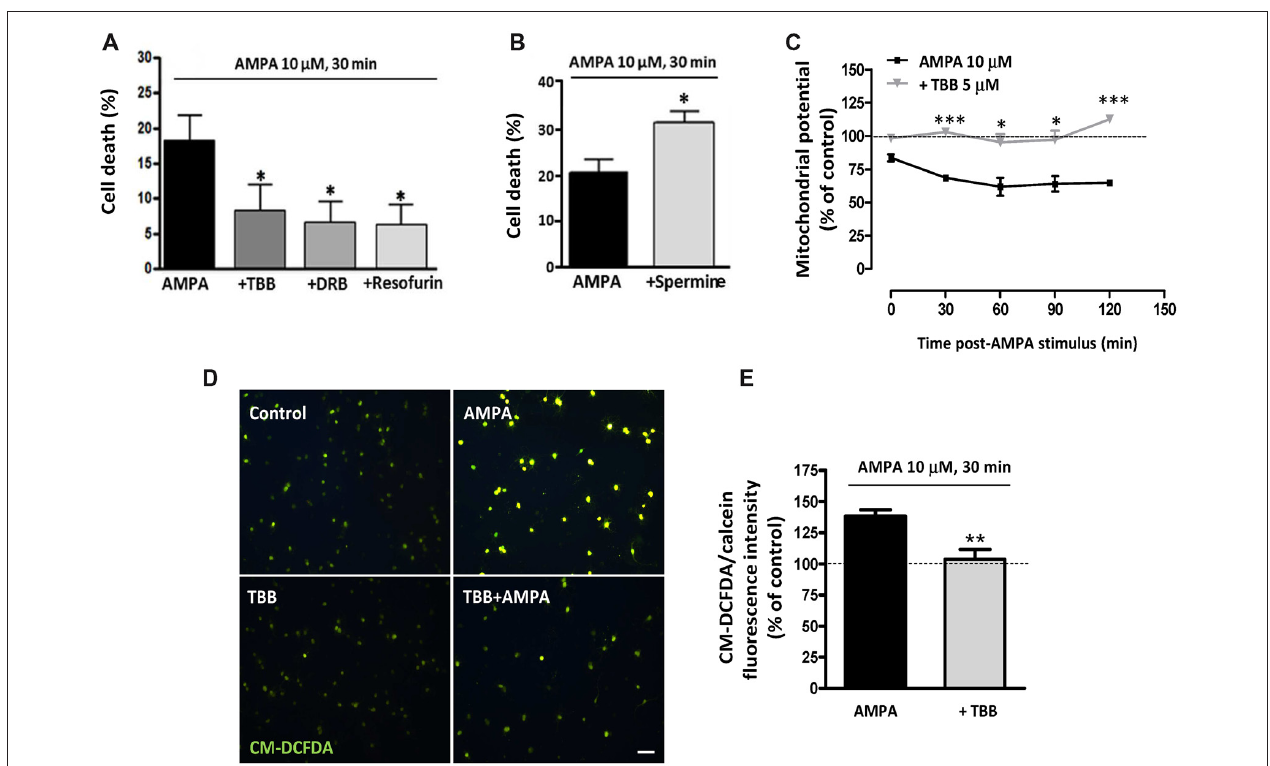
FIGURE 2 | CK2 inhibition protects rat oligodendrocytes from AMPA excitotoxic insults. Oligodendrocyte cultures were isolated from mixed glial culture and used for toxicity assays after 2 days in vitro in differentiation SATO medium. (A) Activation of AMPA receptors with 10 µ M AMPA applied together with 100 µ M cyclothiazide for 30 min, caused oligodendroglial cell death as measured by calcein-AM assay 24 h later. AMPA-induced cytotoxicity was significantly reduced in presence of CK2 inhibitors, 5 µ M TBB, 5 µ M DRB or 5 µ M resofurin and none of these CK2 inhibitors produced alterations in the oligodendrocyte viability when they were used without AMPA (data not shown). The data are shown as mean ± SEM ( n ≥ 4; ∗ p < 0.05 compared with cells treated with AMPA). (B) Pretreatment of cells with CK2 activator spermine (10 µ M) increased cytotoxic consequences derived from AMPA receptor activation in oligodendrocytes. Bars represent mean ± SEM ( n ≥ 3; ∗ p < 0.05 compared with cells treated with AMPA). (C) CK2 inhibitor TBB attenuated loss of mitochondrial membrane potential induced by activation of AMPA receptors. Oligodendrocytes were exposed to 10 µ M AMPA for 30 min in absence or presence of TBB (5 µ M; 3 h pretreatment) and mitochondrial membrane potential was quantified by fluorimetry at the indicated times post-AMPA stimulus, after loading cells with dye JC-1 (3 µ M, Molecular Probes). Decrease of mitochondrial potential triggered by excitotoxic insult was not observed in oligodendrocytes pretreated with 5 µ M TBB. The data are represented as mean ± SEM compared with untreated control cells for each time point analyzed ( n ≥ 4; ∗ p < 0.05, ∗∗∗ p < 0.001). (D,E) ROS generation induced by activation of AMPA receptors was limited in the presence of CK2 inhibitor TBB. Oligodendrocytes were treated similarly as described above and ROS generation was determined